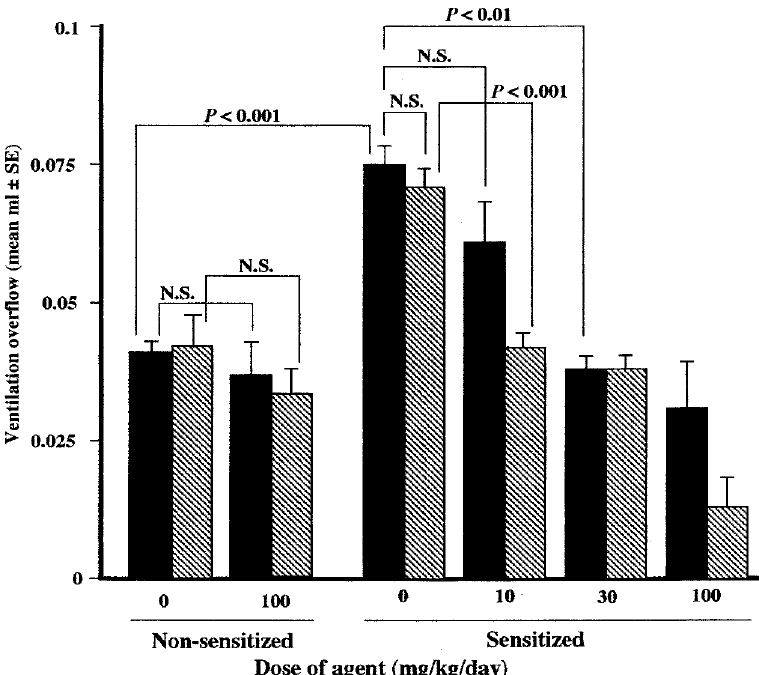
FIG. 4. Influence of suplatast tosilate (IPD–1151T) on bronchoconstriction induced by allergen in actively sensitized BALB/c mice. Mice were sensitized by intraperitoneal injection with DNP-KLH. The mice were administered orally with IPD–1151T for either 5 (starting on Day 9) ( j ) or 14 (starting on Day 0) ( ) days from the day of sensitization. Airway responses to 500 m g of KLH injected intravenously were measured on Day 15, 24h after the final drug administration. This is one of two